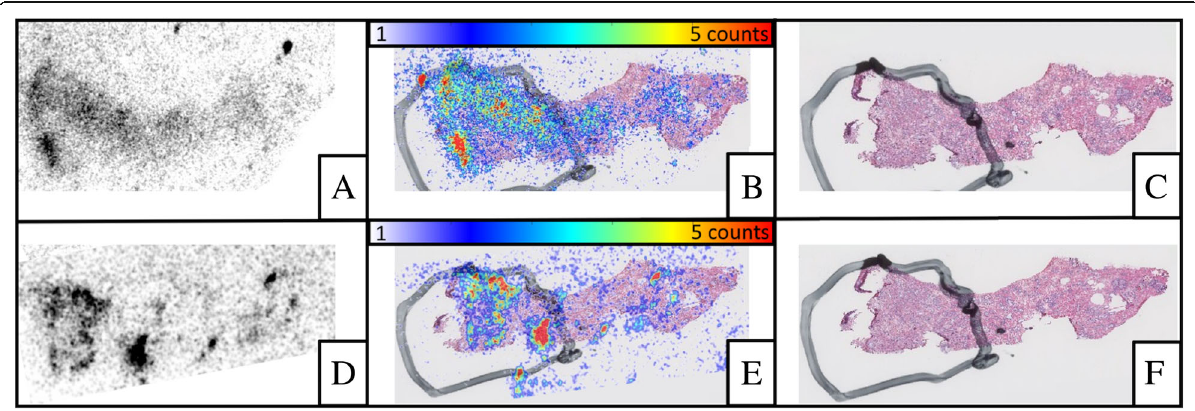
Fig. 1 Comparison between 111 In-RM2 ( a – c ) and 111 In-PSMA ( d – f ) on a low-risk sample: radioactive signal ( a , d ), HES ( c , f ), and fusion images ( b , e ). The black line drawing corresponds to the tumoral area. There is good discrimination between tumor tissue and normal tissue on 111 In-RM2 (tumor-to-normal ratio, TNR = 1.22) as well as on 111 In-PSMA-617 (TNR = 2.09)